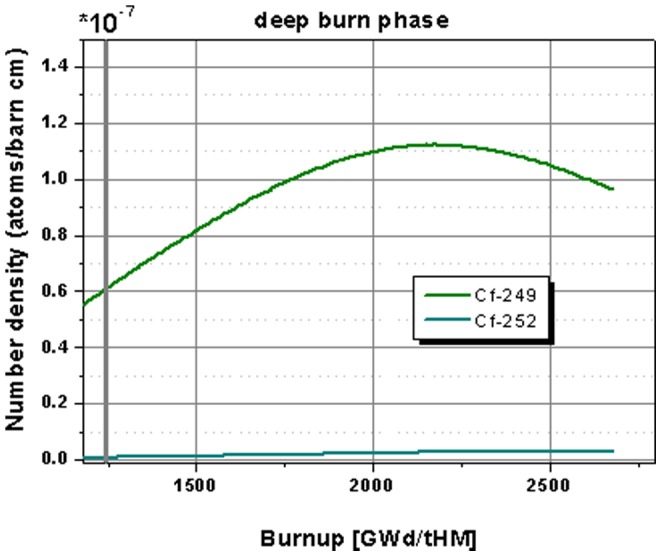
Highlight on the evolution of the californium isotope inventory for the continuation in the deep burn phase.